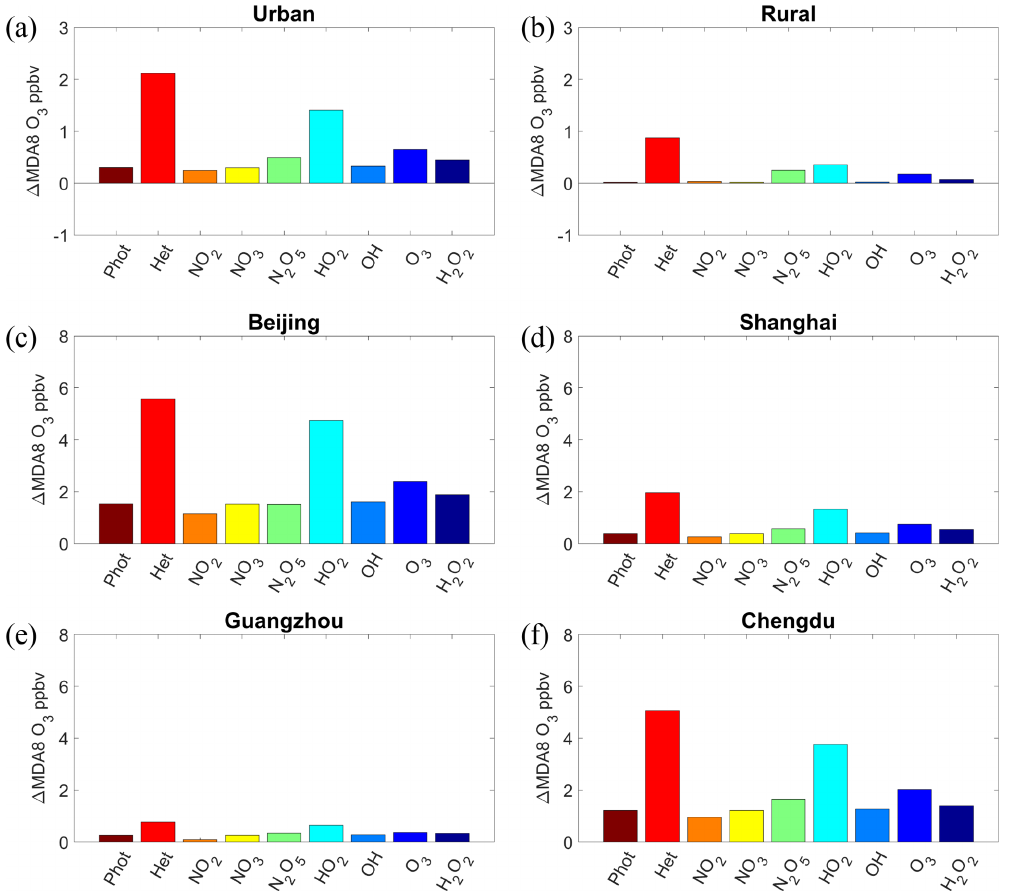
Figure 6. Response of the simulated MDA8 O 3 mixing ratios to the changes in the effects of aerosols in summer from 2013 to 2017 in (a) the urban area, (b) the rural area, (c) Beijing, (d) Shanghai, (e) Guangzhou, and (f) Chengdu. The aerosol affects O 3 via altering the photolysis rates (Phot), all heterogeneous reactions (Het), and individual heterogeneous reactions, namely the uptake of NO 2 , NO 3 , N 2 O 5 , HO 2 , OH, O 3 , and H 2 O 2